Question: What direction does the quantity move in — increasing or decreasing?
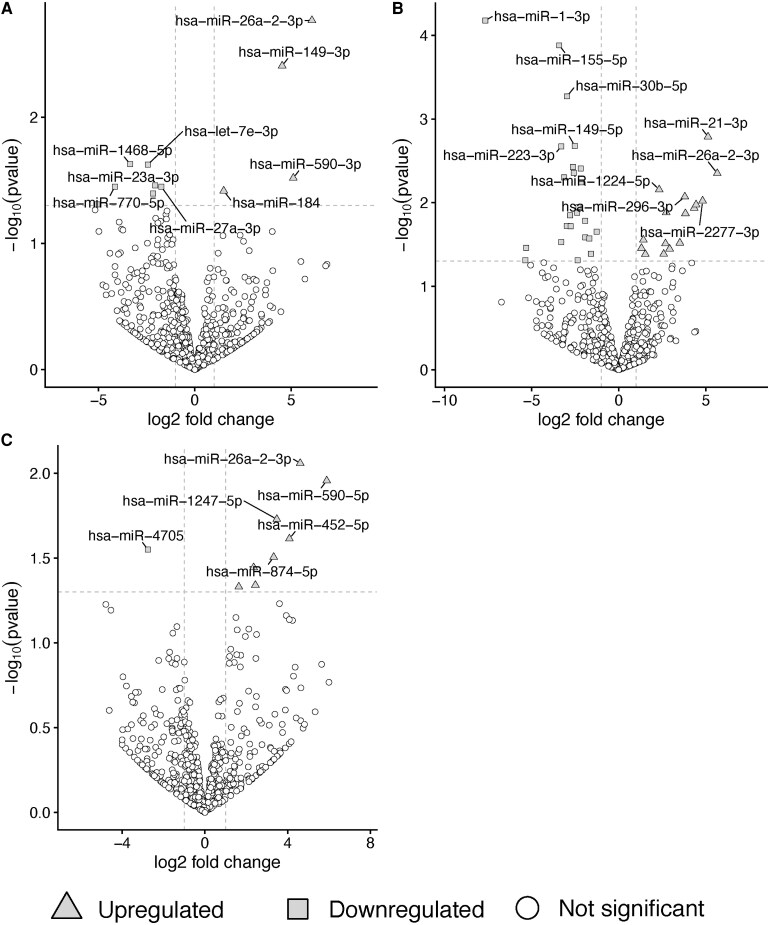
Answer: increasing